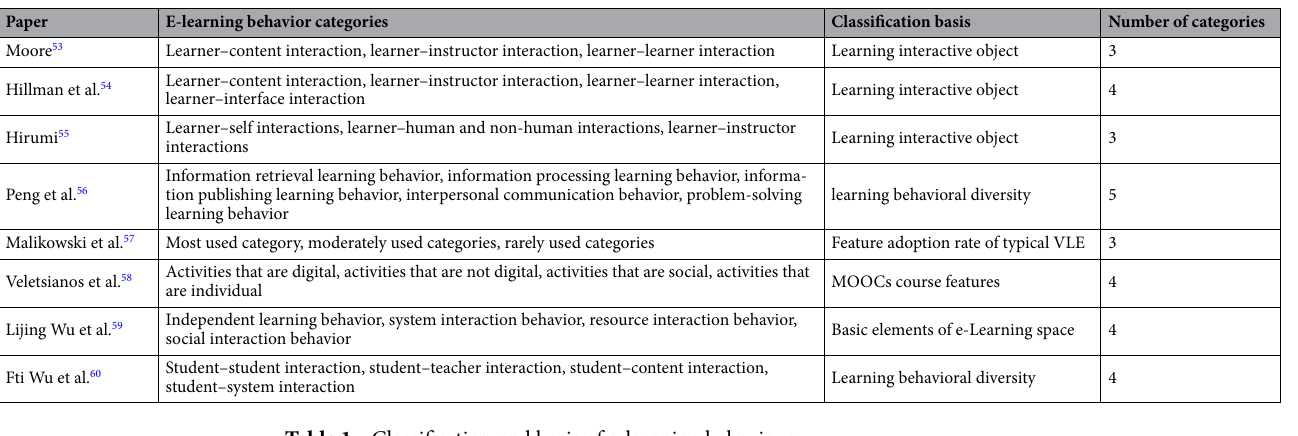
Table 1. Classification and basis of e-learning